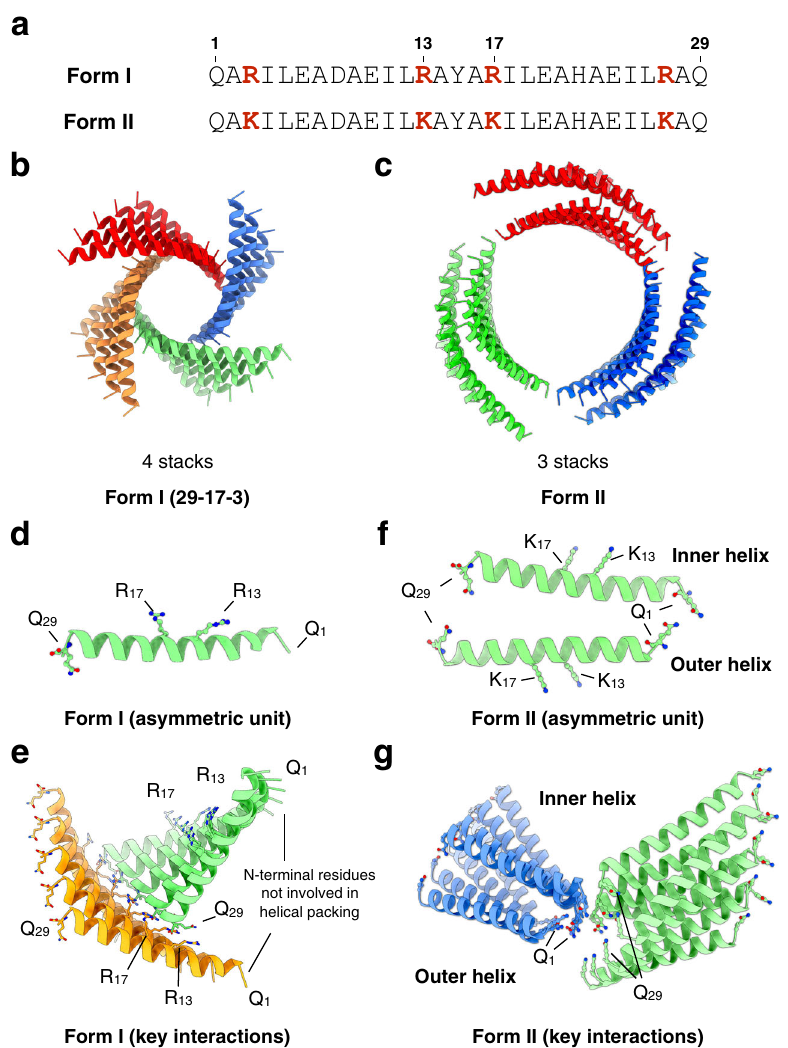
Fig. 1 Structures and critical interactions in the Form peptide fi laments. a The 29-residue sequences of Form I and Form II peptides. b , c Cryo-EM structure of Form I ( b ) and Form II ( c ) fi laments. d The building block (asymmetric unit) of Form I peptide with key residues shown in sticks. e Essential interactions between adjacent helix stacks in Form I fi laments that maintain the helical packing. f The building block (asymmetric unit) of the re-examined Form II peptide with key residues shown in sticks. g Essential interactions between adjacent helix stacks in Form II fi laments that maintain the